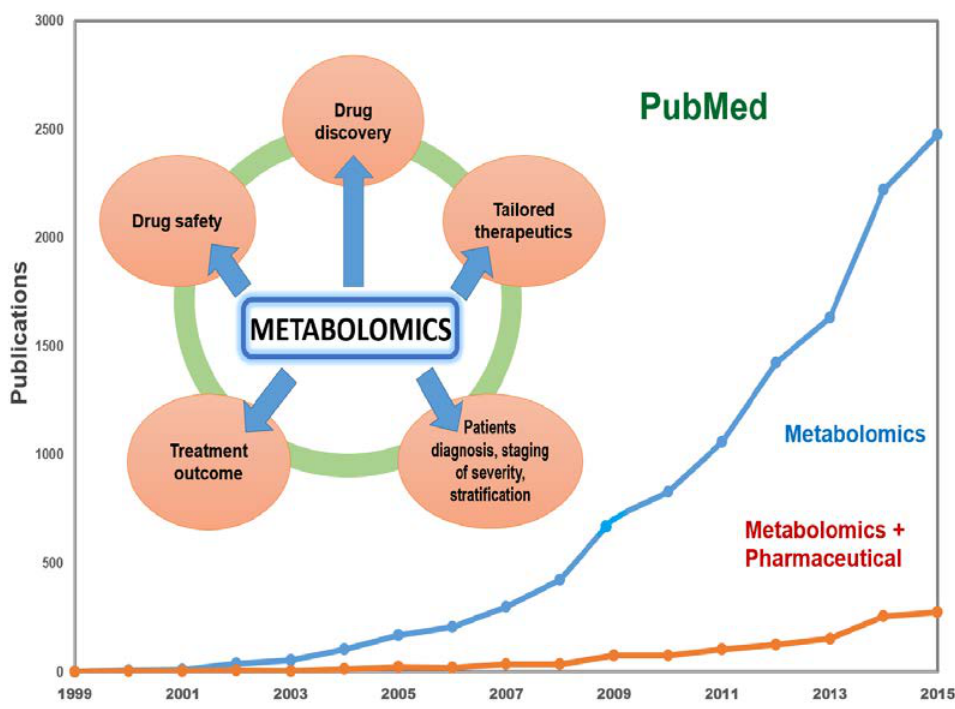
Figure 1. Metabolomics areas of implications as a standalone and/or as a part of systemic omics approach. Metabolomics publication metrics from 1999 through 2015. The line graph (orange line) shows annual number of publications that list key words ((metabolomics OR metabonomics) AND pharmaceutical) from all key words ((metabolomics) OR metabonomics)) containing publications (blue line) derived from the search in PubMed database.